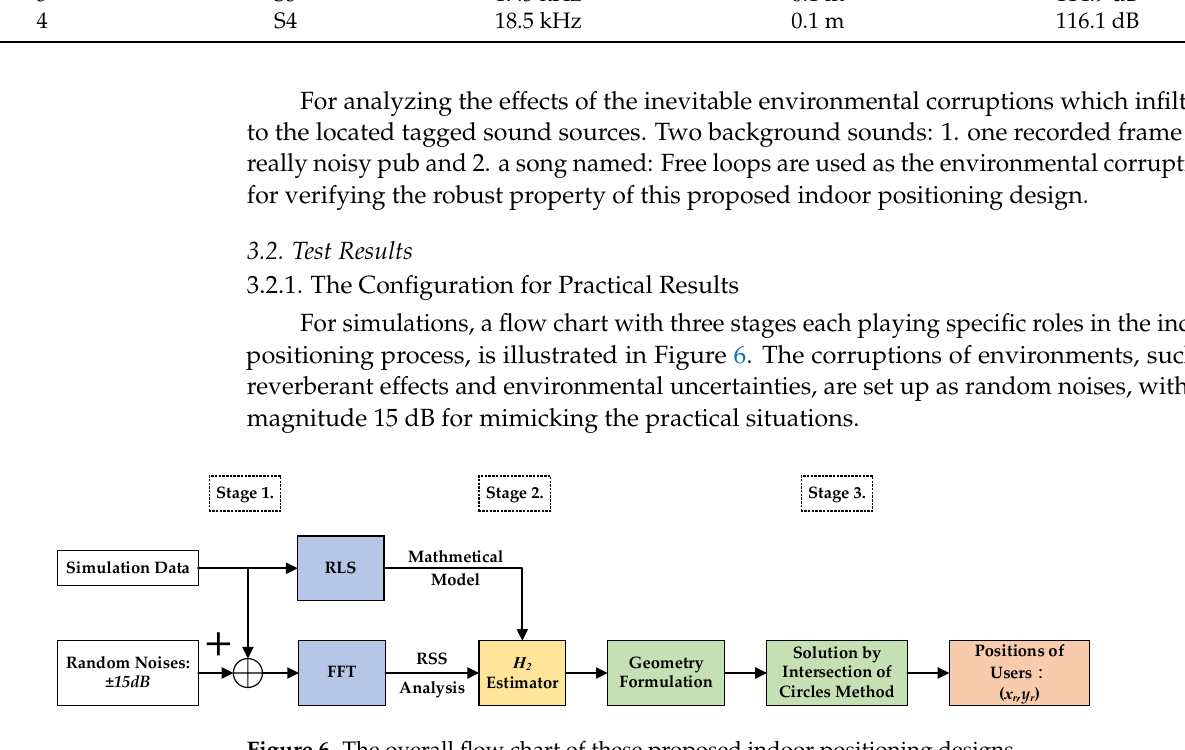
Table 4. Initial values of the proposed H 2 estimation design with respect to the tagged sound source S1.